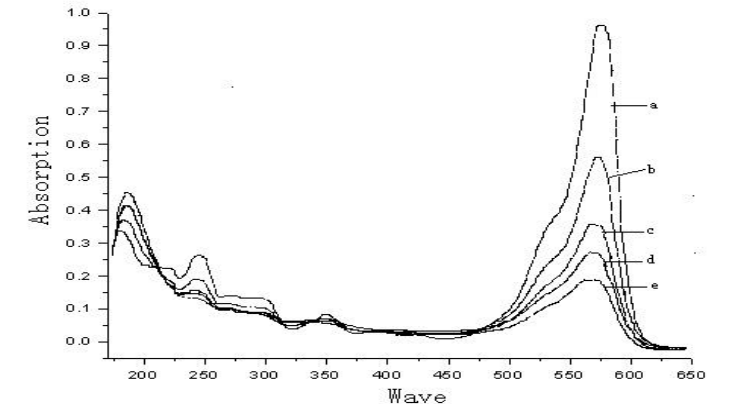
Figure 1. UV absorption spectra of aqueous solution of methyl violet at different sonication times: a. 0 min; b. 30 min; c. 30 min; d. 90 min; e. 120 min.